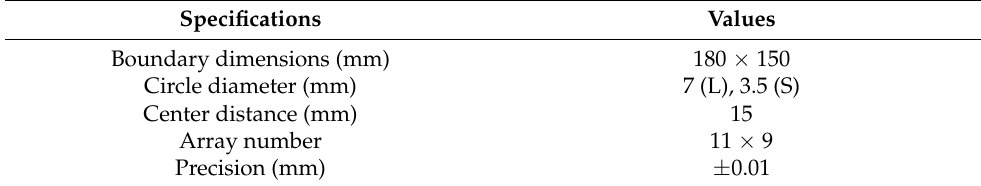
Figure 11. The acquired image of the calibration board. Table 1. The specification of the target.